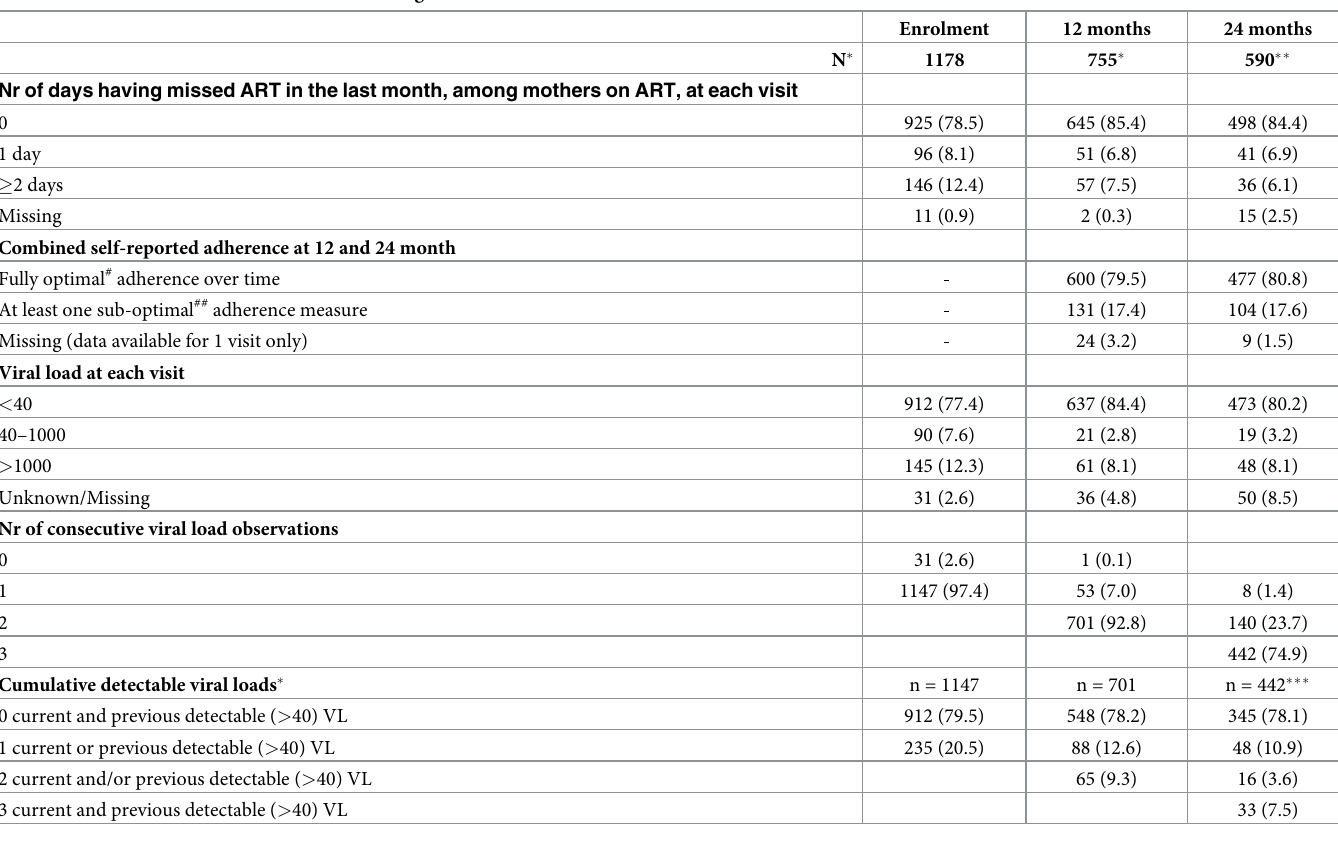
Table 2. Adherence and viral load over time among mothers on